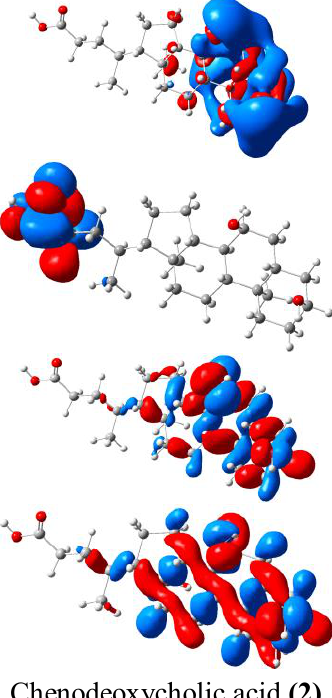
Table 8: The calculated HOMO-LUMO energy (a.u.) and HOMO-LUMO band gap E g values for 1 - 2 using DFT method at B3LYP/ 6-31G( d ) level. 1